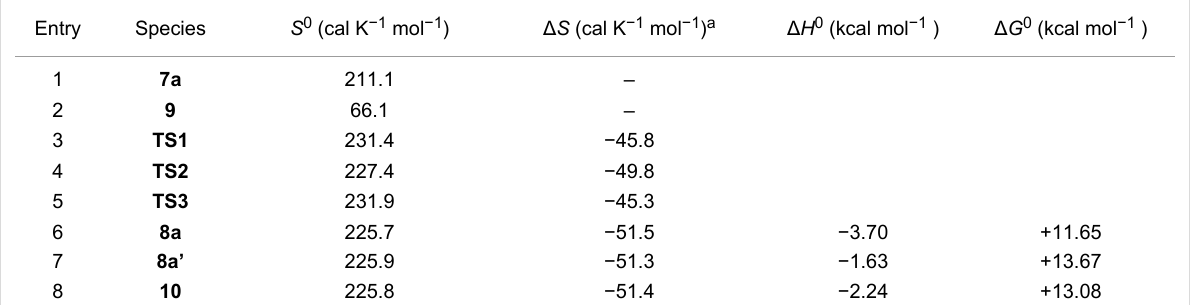
Table 1: Standard state entropies S 0 , entropy change Δ S , reaction enthalpies Δ H 0 and reaction Gibbs free energies Δ G 0